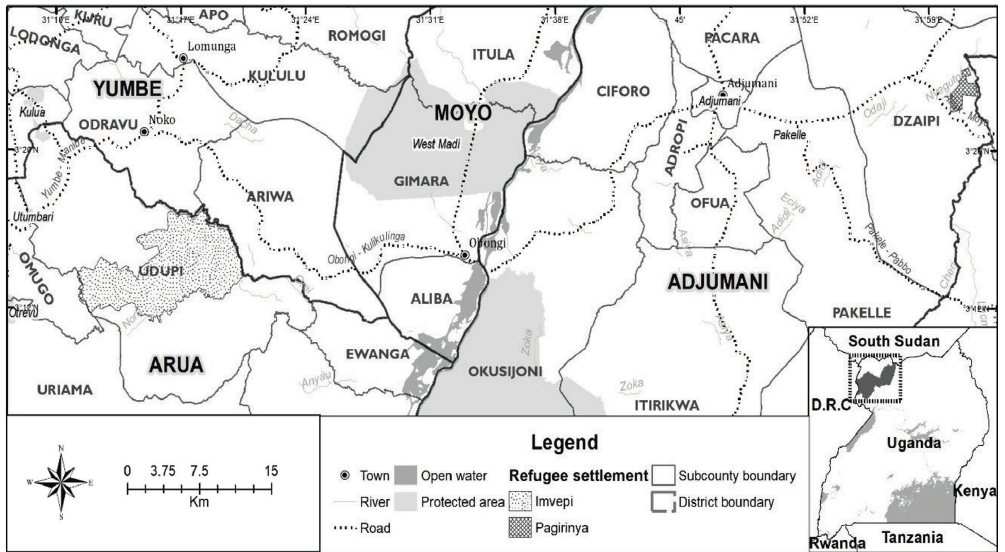
Figure 2: Location of the study